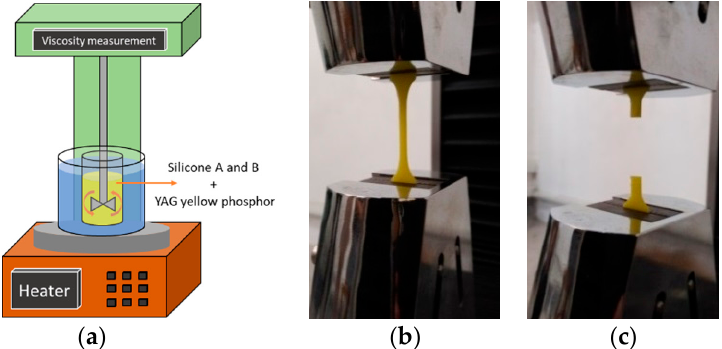
Figure 4. ( a ) the curing experimental setup; and tensile testing setup; ( b ) before testing; ( c ) after testing.